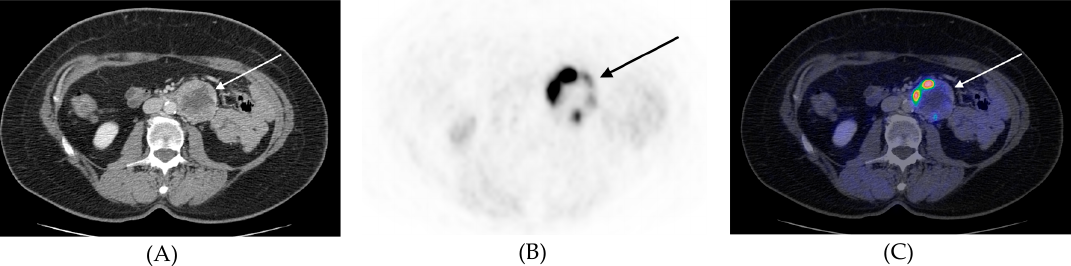
Figure 2. Transverse 11 C-HED-PET/CT images, ( A ) CT, ( B ) PET, ( C ) PET/CT fusion, of patient #21 (Table 4) with a retroperitoneal paraganglioma left of the descending aorta (arrows). In this paraganglioma there was extended necrosis and merely peripheral tracer accumulation in the